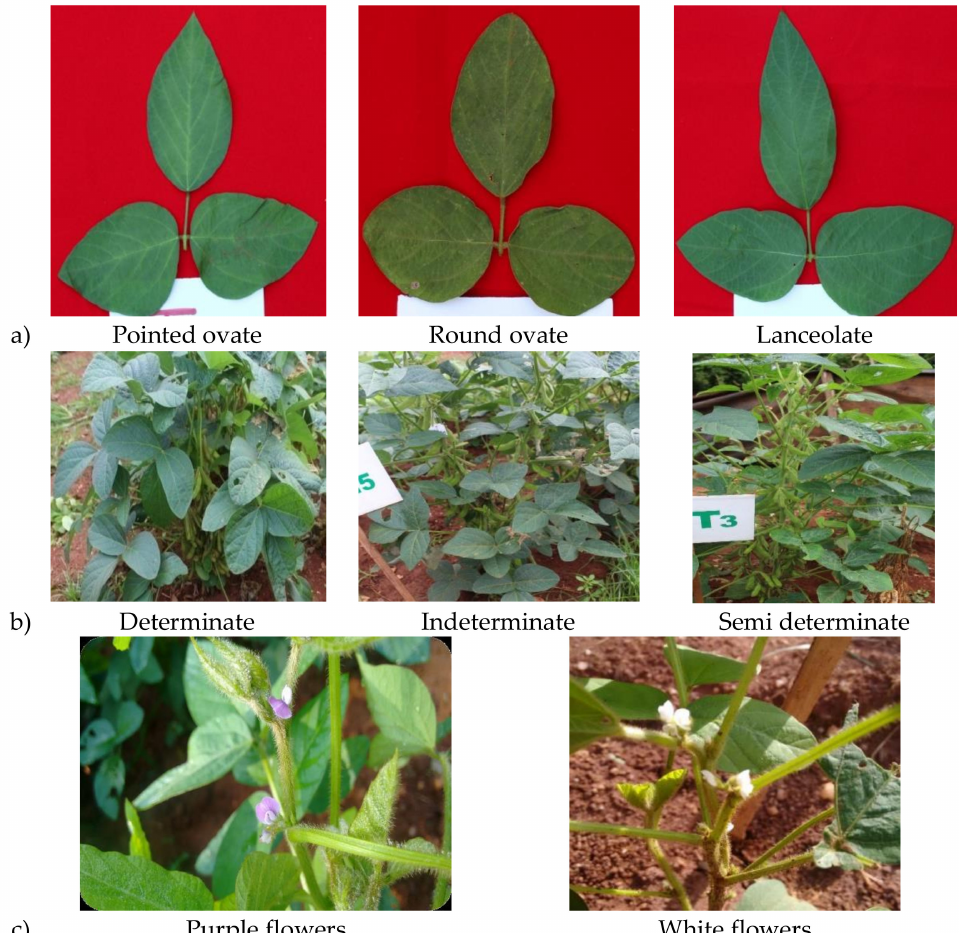
Figure 1. Morphological variabilities among the genotypes of vegetable soybean, ( a ) variability in leaf shape, ( b ) variability in plant habit and ( c ) variability in flower